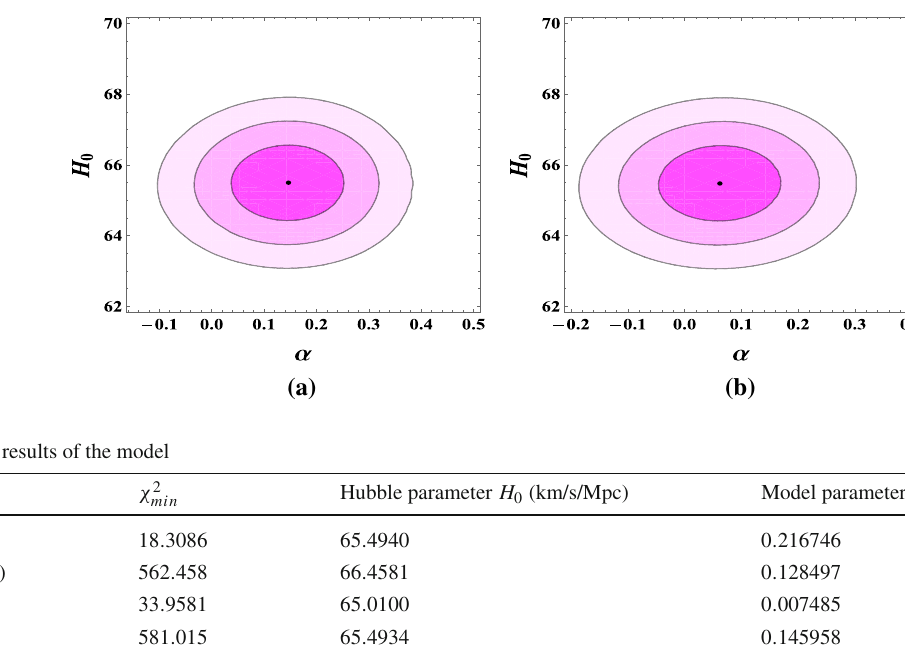
Hubble parameter H 0 (km/s/Mpc) Model parameter α min